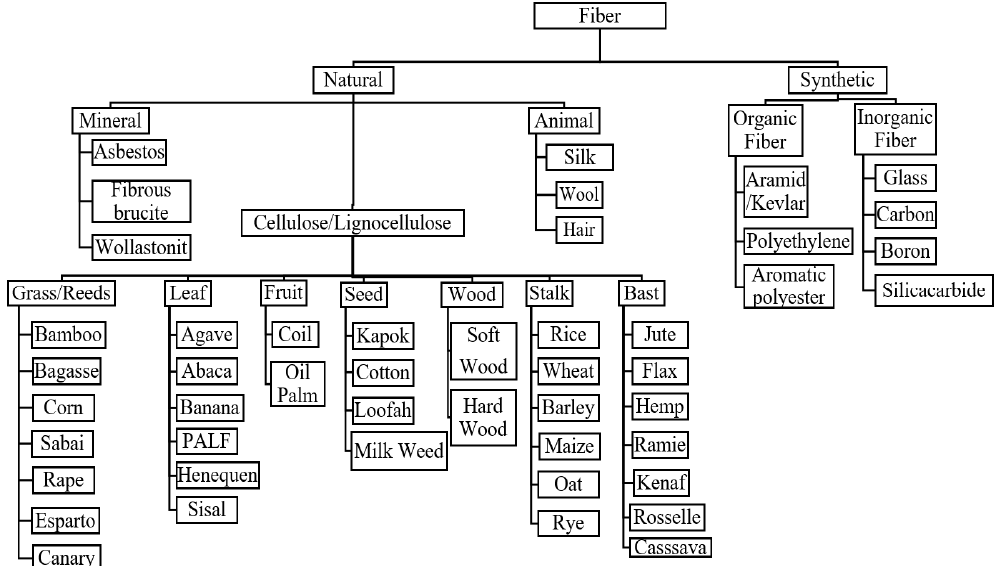
Figure 1. Classification of natural fibers. Table 2. Advantages and disadvantages of natural fibers .